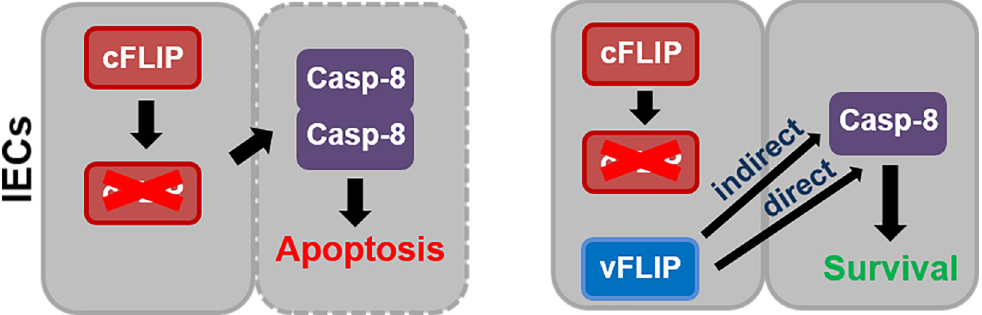
Fig 6. Potential influence of vFLIP in a short term apoptosis model. cFlip -deficiency in IECs mediates uncontrolled Caspase-8 activation culminating into increased apoptosis. Additional vFlip expression during viral infection might either directly or indirectly via NF κ B compensate for loss of cFLIP, finally blocking apoptotic cell death to circumvent host defense reactions.